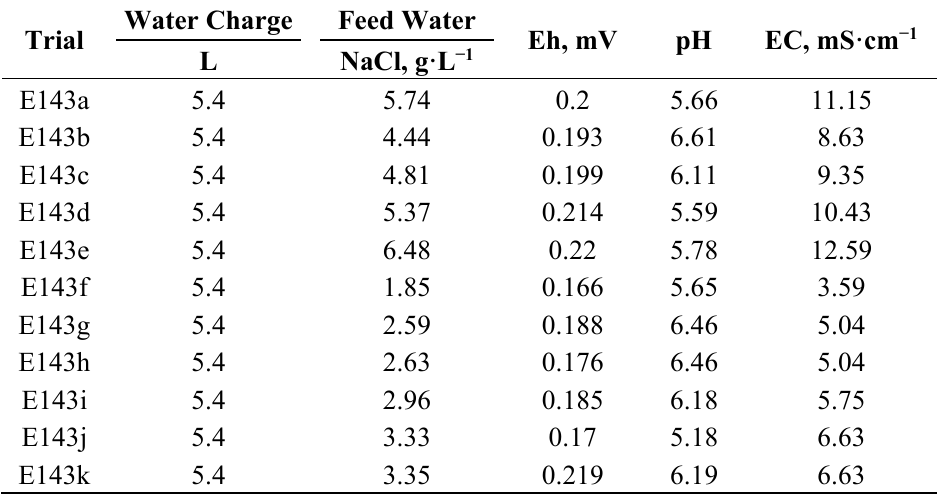
Table C5. ZVM TPA Example (Trial E143): Feed Water Composition.